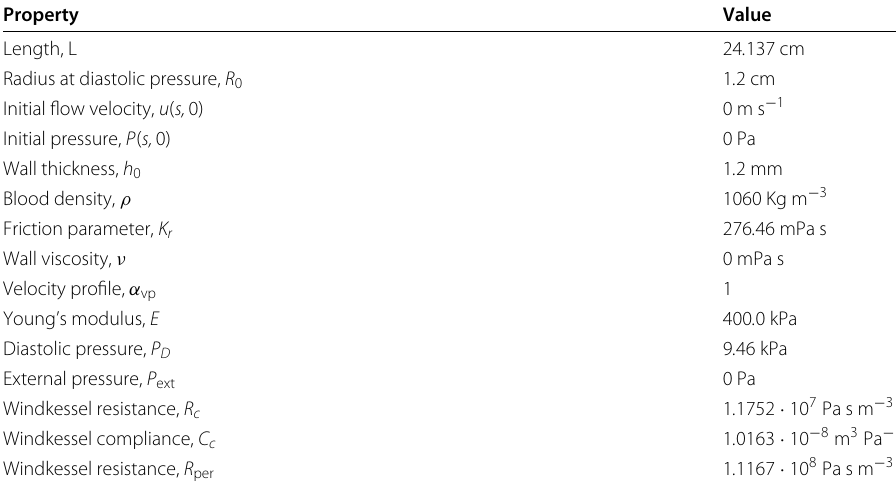
Table 1 Model parameters of the upper thoracic aorta (Readapted from [23]) Property Value Length, L 24 . 137 cm Radius at diastolic pressure, R 0 1 . 2 cm Initial flow velocity, u ( s, 0) 0 m s − 1 Initial pressure, P ( s, 0) 0 Pa Wall thickness, h 0 1 . 2 mm Blood density, ρ 1060 Kg m − 3 Friction parameter, K r 276 . 46 mPa s Wall viscosity, ν 0 mPa s Velocity profile, α vp 1 Young’s modulus, E 400 . 0 kPa Diastolic pressure, P D External pressure, P